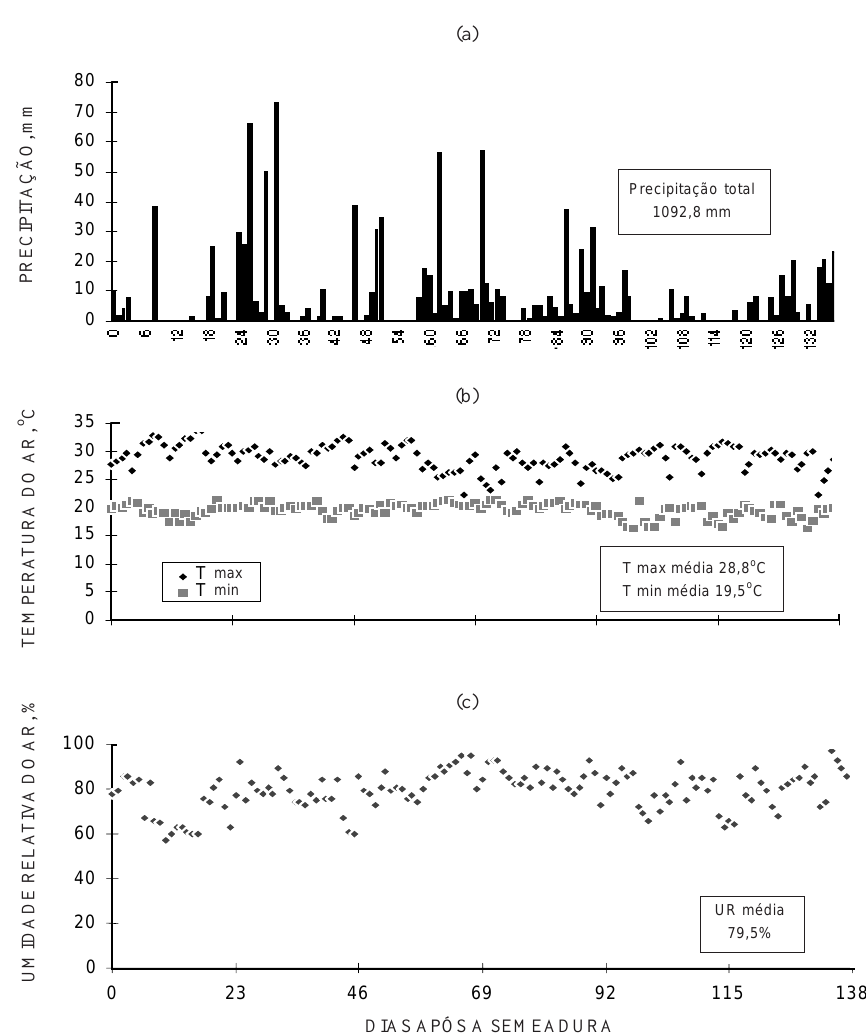
Figura 1. Elementos do clima durante a primeira época de semeadura (12 de novembro de 1991): (a) precipitação (mm dia -1 ); (b) temperaturas máximas e mínimas do ar (ºC); (c) umidade relativa média do ar